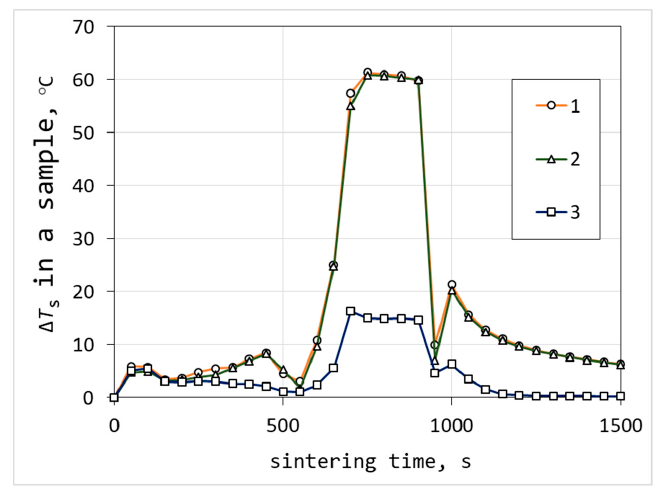
Figure 10. Dependence of maximum temperature difference in the sample volume on sintering time: With thermoelectric effect and contact resistances (1); with thermoelectric effect and without contact resistances (2); and without thermoelectric effect and contact resistances (3).